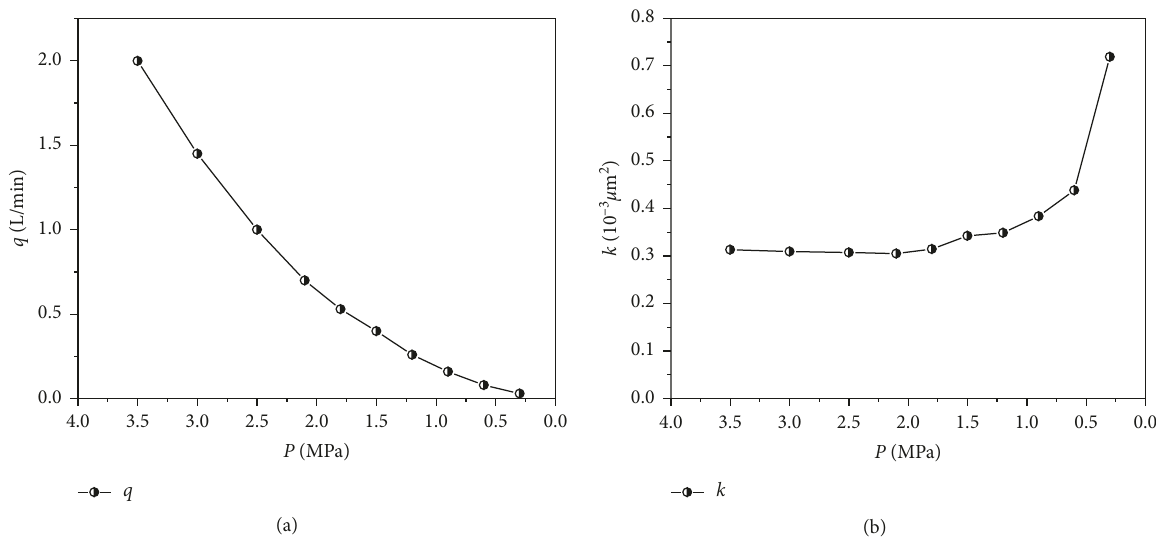
Figure 3: (a) Relationship between gas pressure and flow rate and (b) relationship between gas pressure and permeability during gas depressurization extraction.